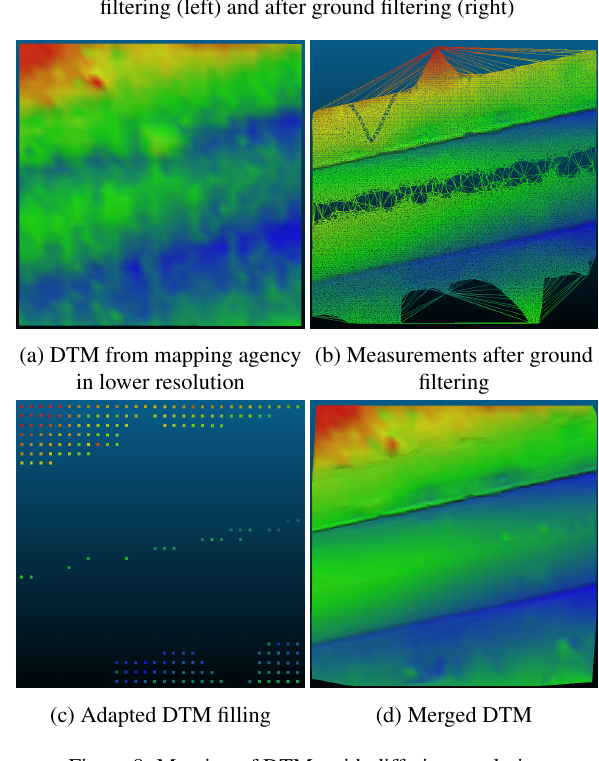
Figure 8. Merging of DTMs with differing resolution